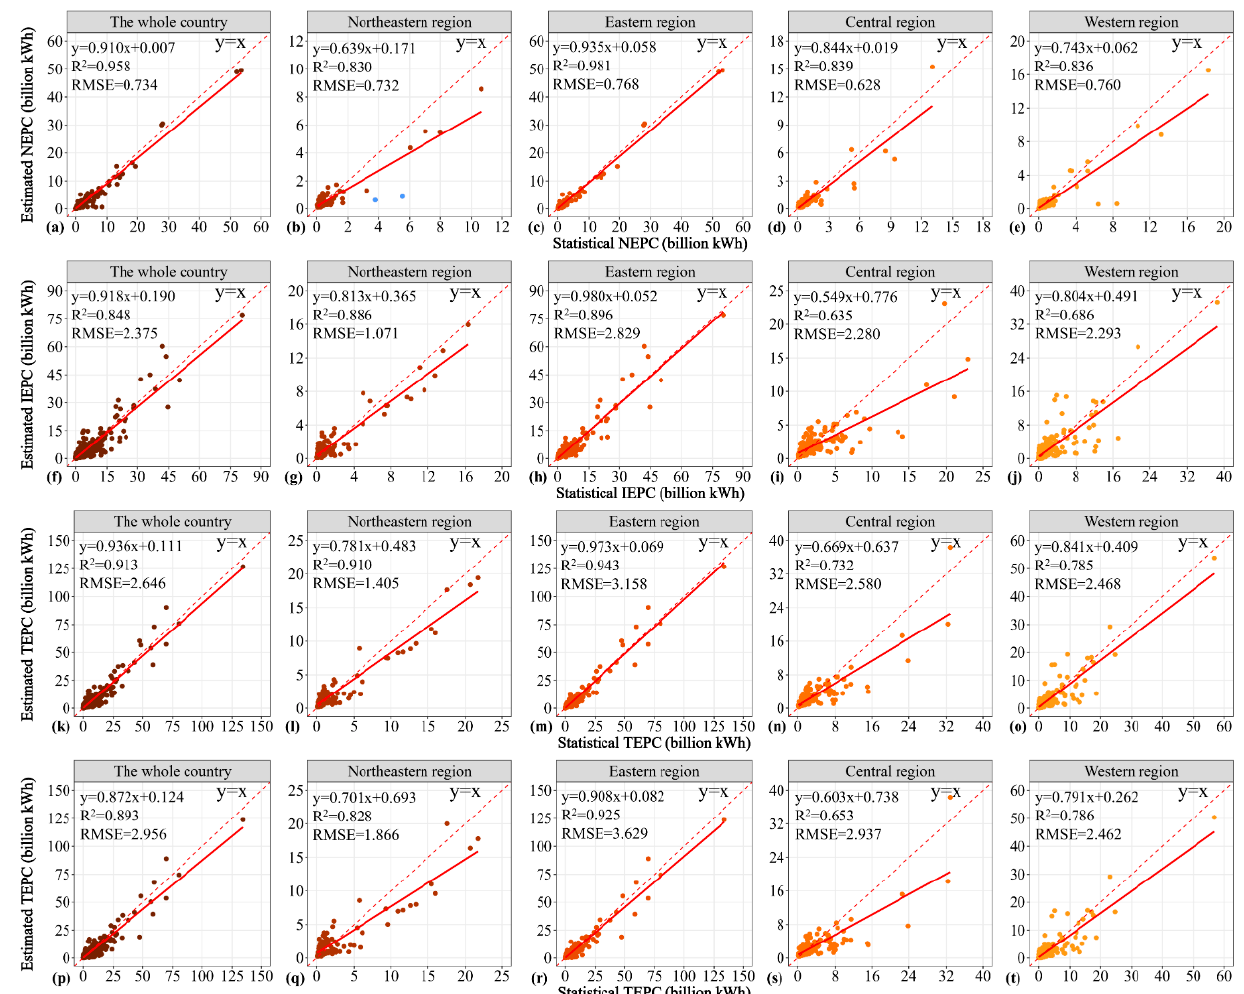
Figure 6. Accuracy assessment of the estimated EPC for China, northeastern China (NEC), eastern China (EC), central China (CC), and western China (WC), with 817, 115, 290, 165, and 247 counties, respectively. ( a – e ) Statistical NEPC versus estimated NEPC; ( f – j ) statistical industrial EPC (IEPC) versus estimated IEPC; ( k – o ) statistical total EPC (TEPC) versus estimated TEPC with points of interest (POIs); ( p – t ) statistical TEPC versus estimated TEPC without POIs. Table 2. Statistics for the comparison of the performance of different EPC prediction methods.